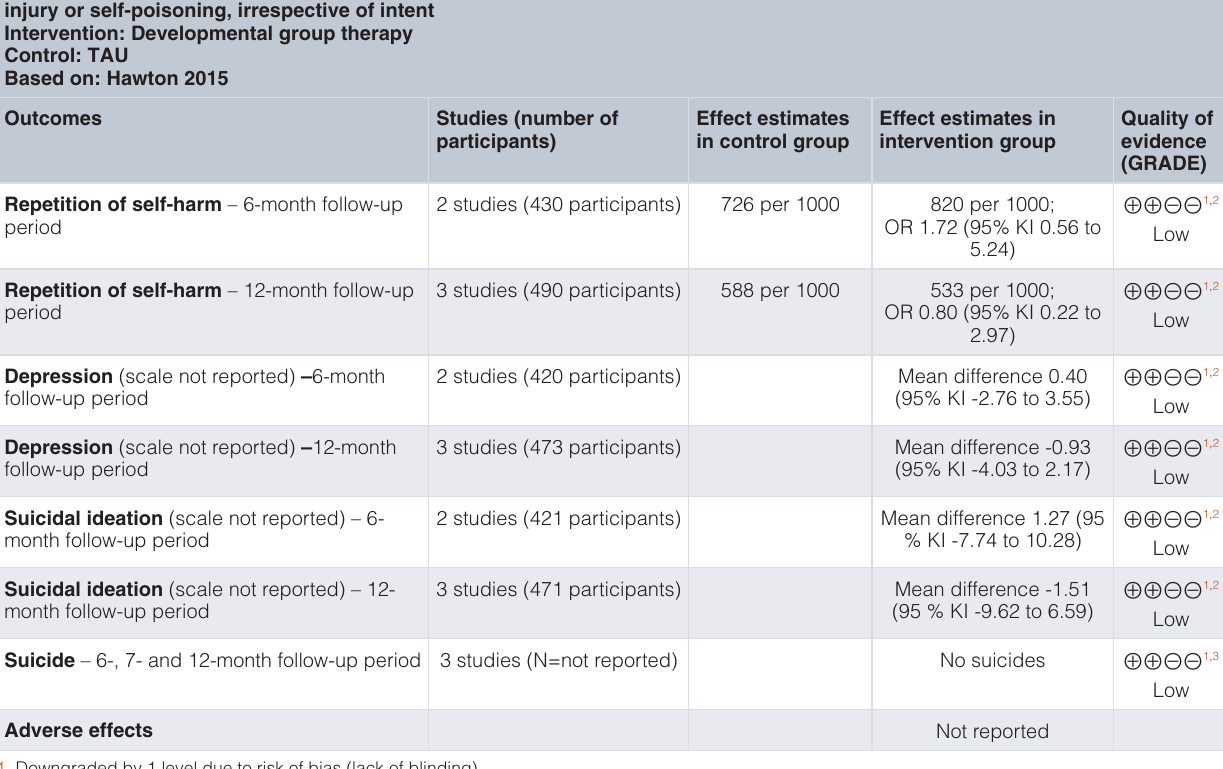
Table 11. GRADE-assessment: Interventions for existing self-harm: developmental group therapy versus treatment as usual (TAU). Population: Adolescents, 12 to 17-year olds, referred to child and adolescent services following an episode of intentional self- injury or self-poisoning, irrespective of intent Intervention: Developmental group therapy Control: